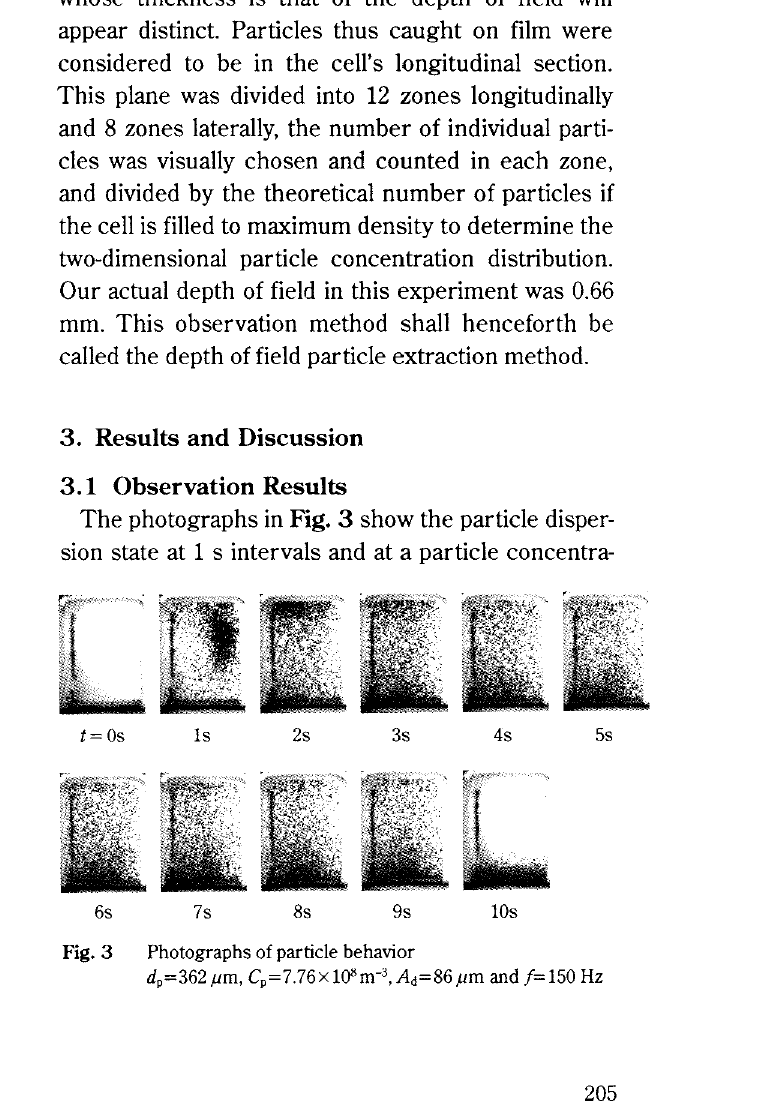
Fig. 2 Method of particle sampling in depth of field